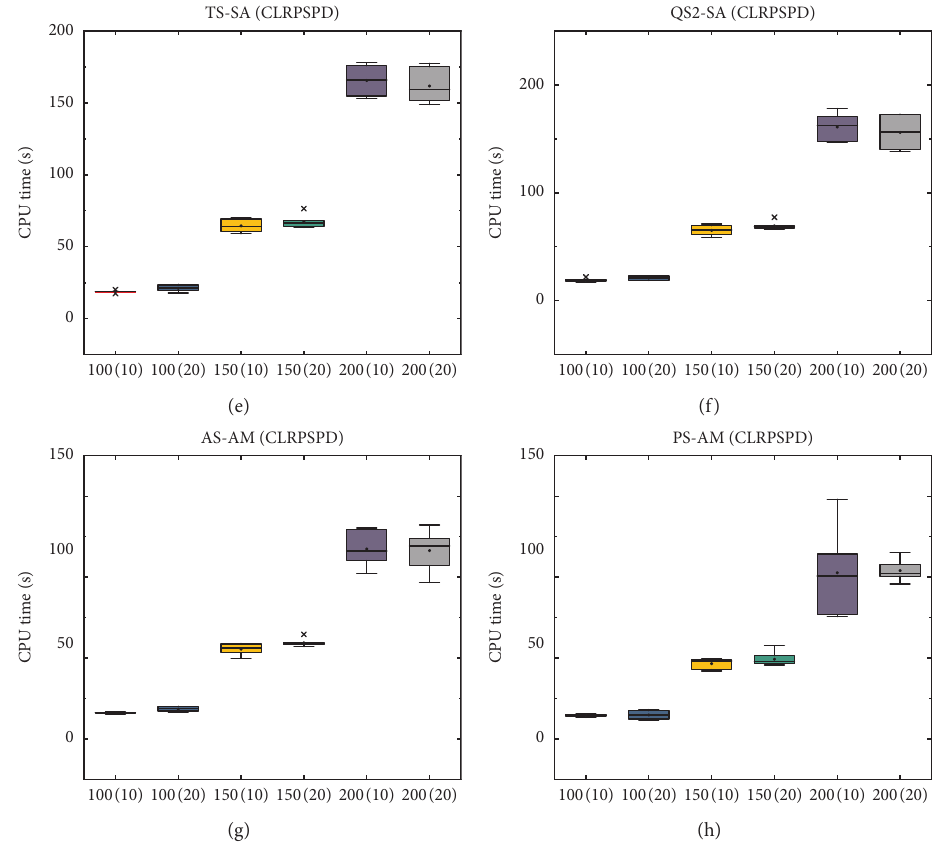
Figure 4: Box plots for relationship between computing time and number of depots.